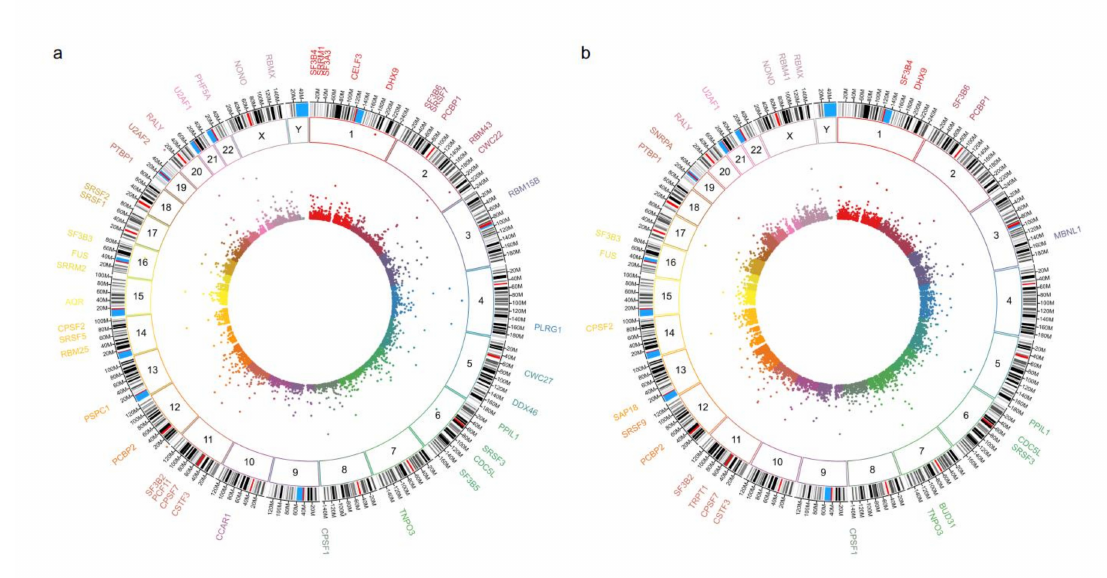
Figure 4. Panel ( a , b ) show the circos plot of the di ff erentially mRNA expressed genes (inner circle), the chromosome (middle circle) and the proteins (outer circle) related to Spliceosome machinery or splicing events in NR5A1 - and POU1F1 -derived pituitary tumors, respectively.